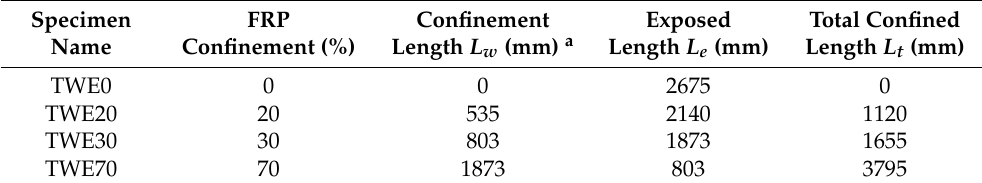
Figure 2. Three-point bending and equivalent cantilevers for tested specimens (units in mm).